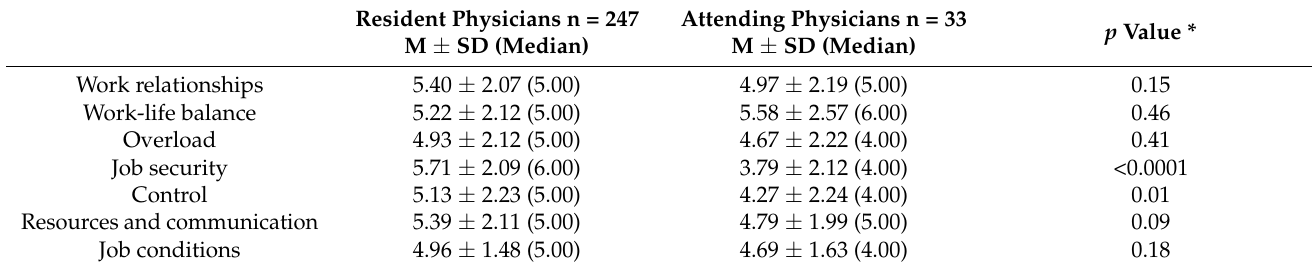
Table 4. Comparison between physicians regarding the level of